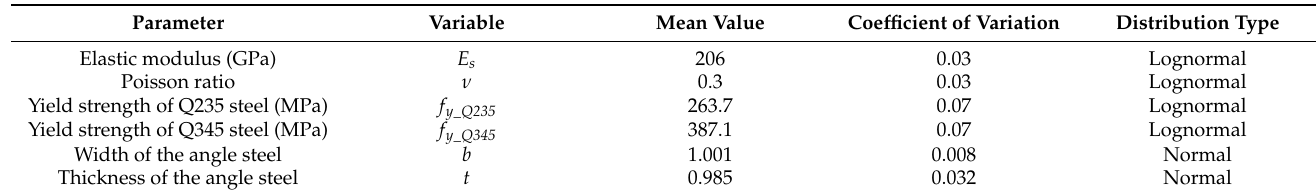
Table 2. Probability distributions of material and geometric